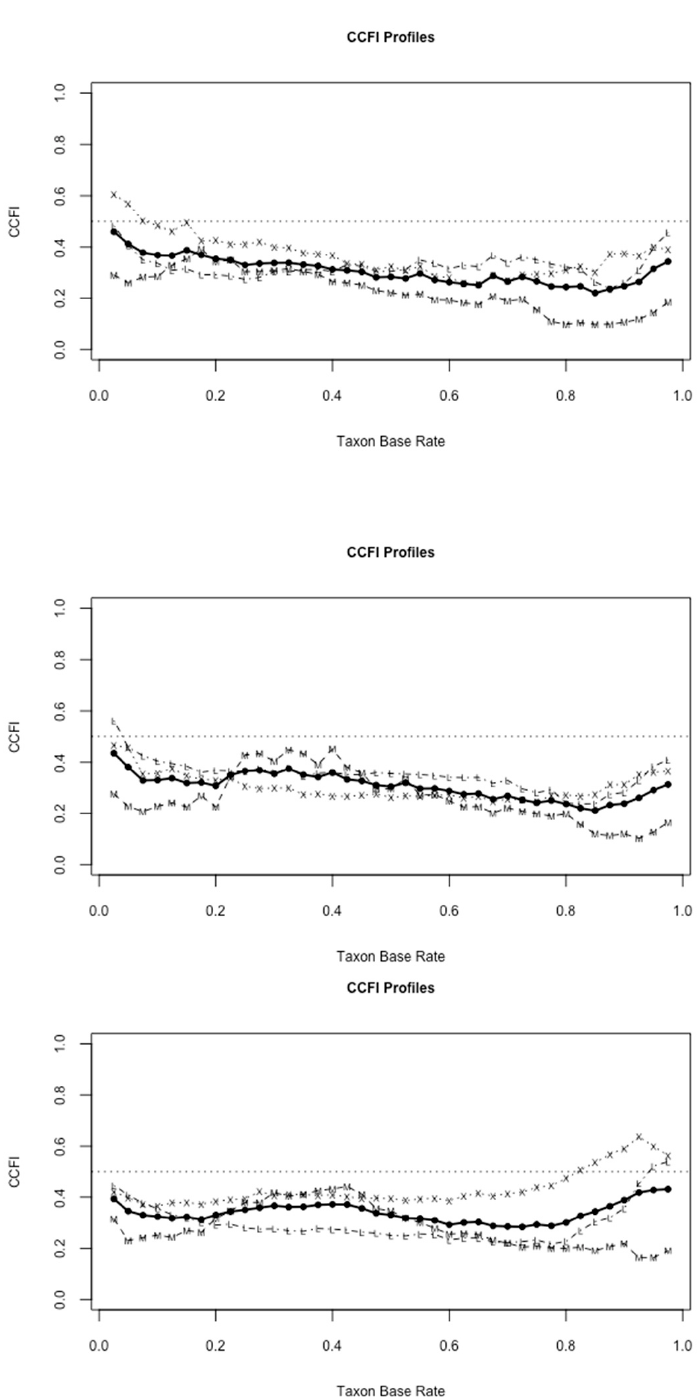
Figure 2. CCFI profiles from taxometric analyses of three unique sets of CFQ indicators. M = MAMBAC, X = MAXEIG, L = L-MODE, and solid dots = the average CCFI.